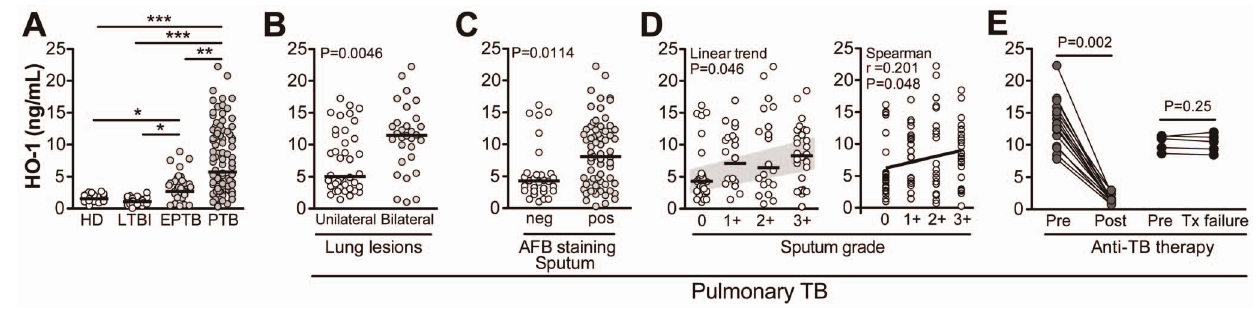
Figure 1. HO-1 levels associate with disease severity and sputum positivity in tuberculosis. ( A ) HO-1 levels were evaluated in plasma samples from 97 individuals with active pulmonary tuberculosis (PTB), 35 with active extra pulmonary tuberculosis (EPTB), 39 with latent M. tuberculosis infection (LTBI) and 40 healthy donors (HD). The samples were collected prior to initiation of anti-tuberculosis treatment (ATT). Kruskal- Wallis test and Dunn’s multiple comparisons were used to evaluate statistical differences between the groups. ( B ) HO-1 levels were compared between 40 PTB patients with a diagnosis of unilateral lung lesions and 37 patients with bilateral lesions identified by chest radiography. ( C ) PTB cases were classified according to the presence or absence of the acid fast staining bacilli (AFB) in sputum samples. In ( B ) and ( C ), the Mann Whitney test was used for statistical comparisons. ( D ) PTB cases were stratified according to the quantitative bacillary sputum grade determined by AFB staining. Data was analyzed using the Kruskal-Wallis test with linear trend post-test (left panel) or by Spearman correlation (right panel). In ( A ), ( B ), ( C ) and ( D ), bars represent median values. ( E ) Comparison of HO-1 levels pre and post ATT in a subset of patients with PTB for which plasma samples were available (n=33). Data from 5 patients that failed treatment are also shown. The Wilcoxon matched pairs test was used to evaluate the